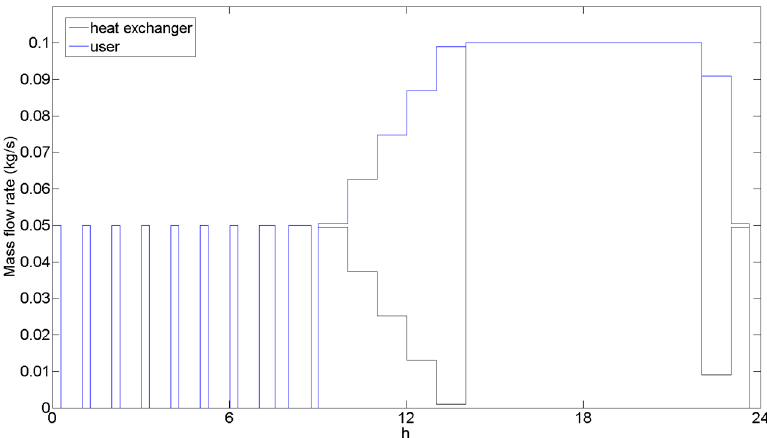
Figure 16. HTF mass flow rate through the PCM tank heat exchanger and the user.